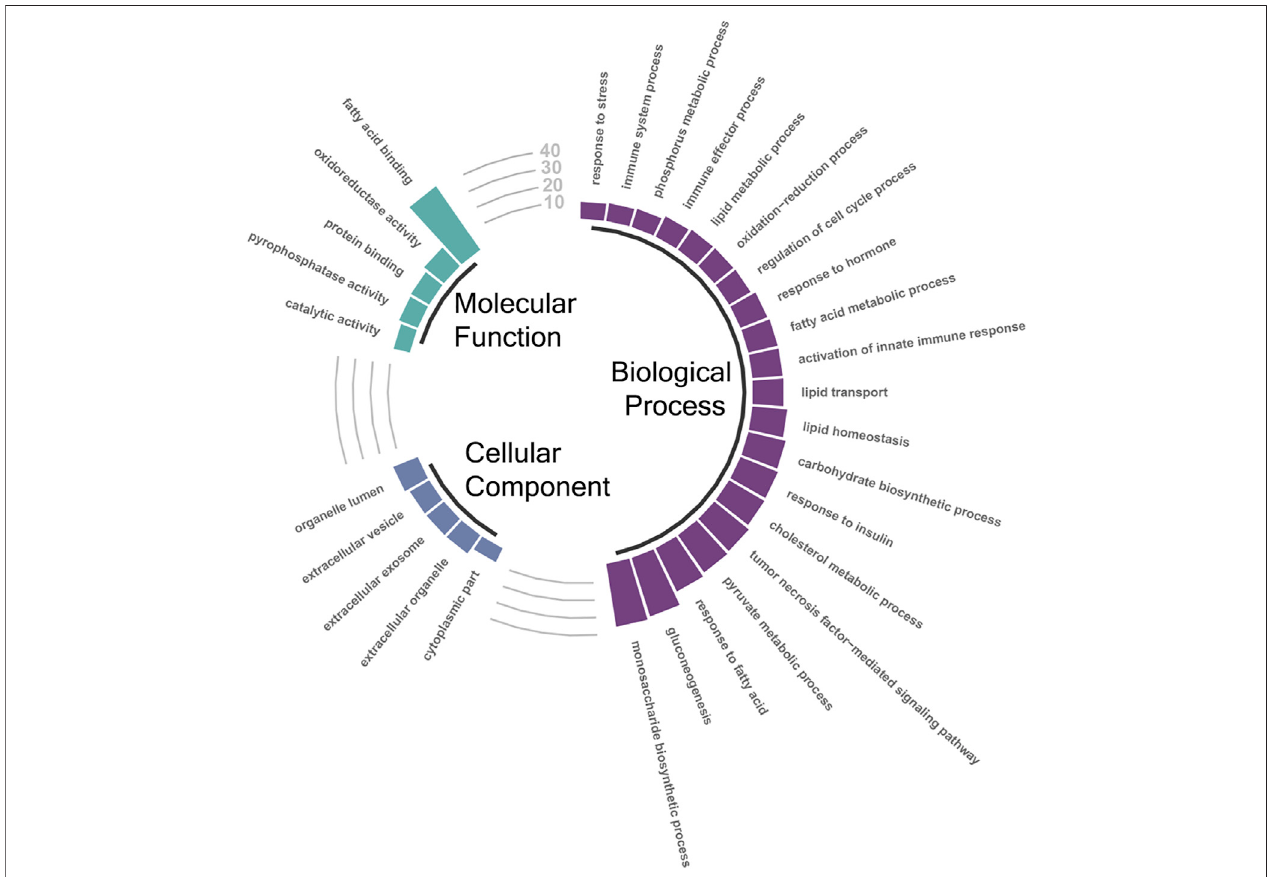
FIGURE 3 | Selected signi fi cantly enriched (FDR-adjusted p < 0.05) gene ontology (GO) terms associated with signi fi cantly differentially expressed transcripts (DETs; both up- and down-regulated) between the 10.5 ° C and 16.5 ° C groups. The height of the bars represents the percentage of DETs found in the current study comparedtototalnumberoftranscriptsassignedtothatspeci fi cGOterm.AfulllistofenrichedGOtermsidenti fi edbetweenthe10.5 ° Cand16.5 ° Cgroupscanbefound in Supplementary Table S4